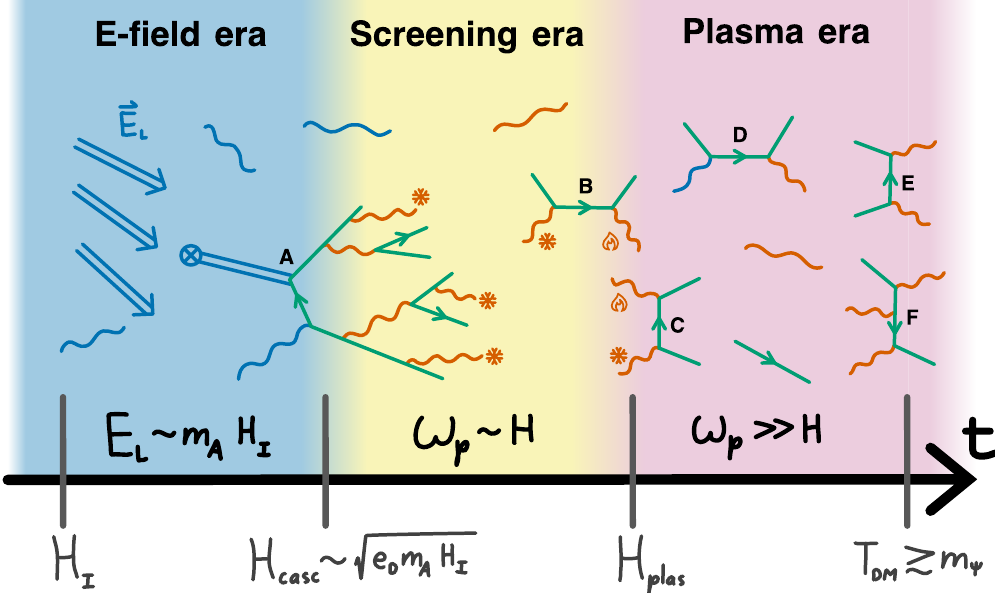
Figure 4. A graphical summary of the thermalization process for m A 0 (cid:28) m ψ . As the A 0 modes L (in blue in the figure) that were gravitationally produced during inflation re-enter the horizon, they induce a large dark electric field E 0 ∼ m A 0 H I (marked by blue double arrows). Strong L field processes like cascade (and possibly Schwinger) pair production create ψψ pairs (shown in green). As these are accelerated in the E 0 field, they radiate transverse A 0 photons (in orange) T of typically soft momentum H (denoted by d ). At early times (“ E -field era”) the n ψ dilution due to the Hubble expansion is strong, and prevents a full electromagnetic cascade (process A ) until p H < H casc ∼ e d E 0 . Starting from H casc , the system enters the “Screening era” in which L